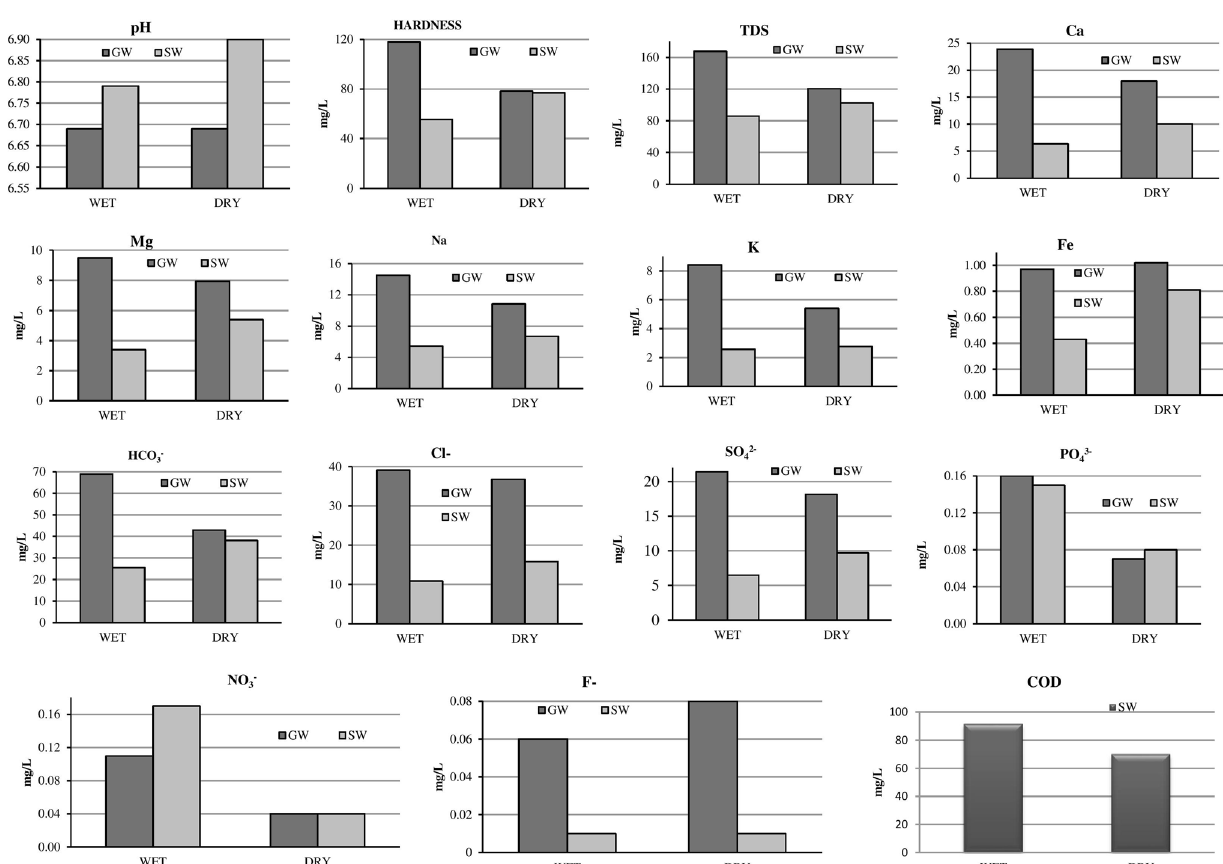
Fig. 2 Bar diagram of the hydrochemical parameters of GW and SW sources in both the wet and dry